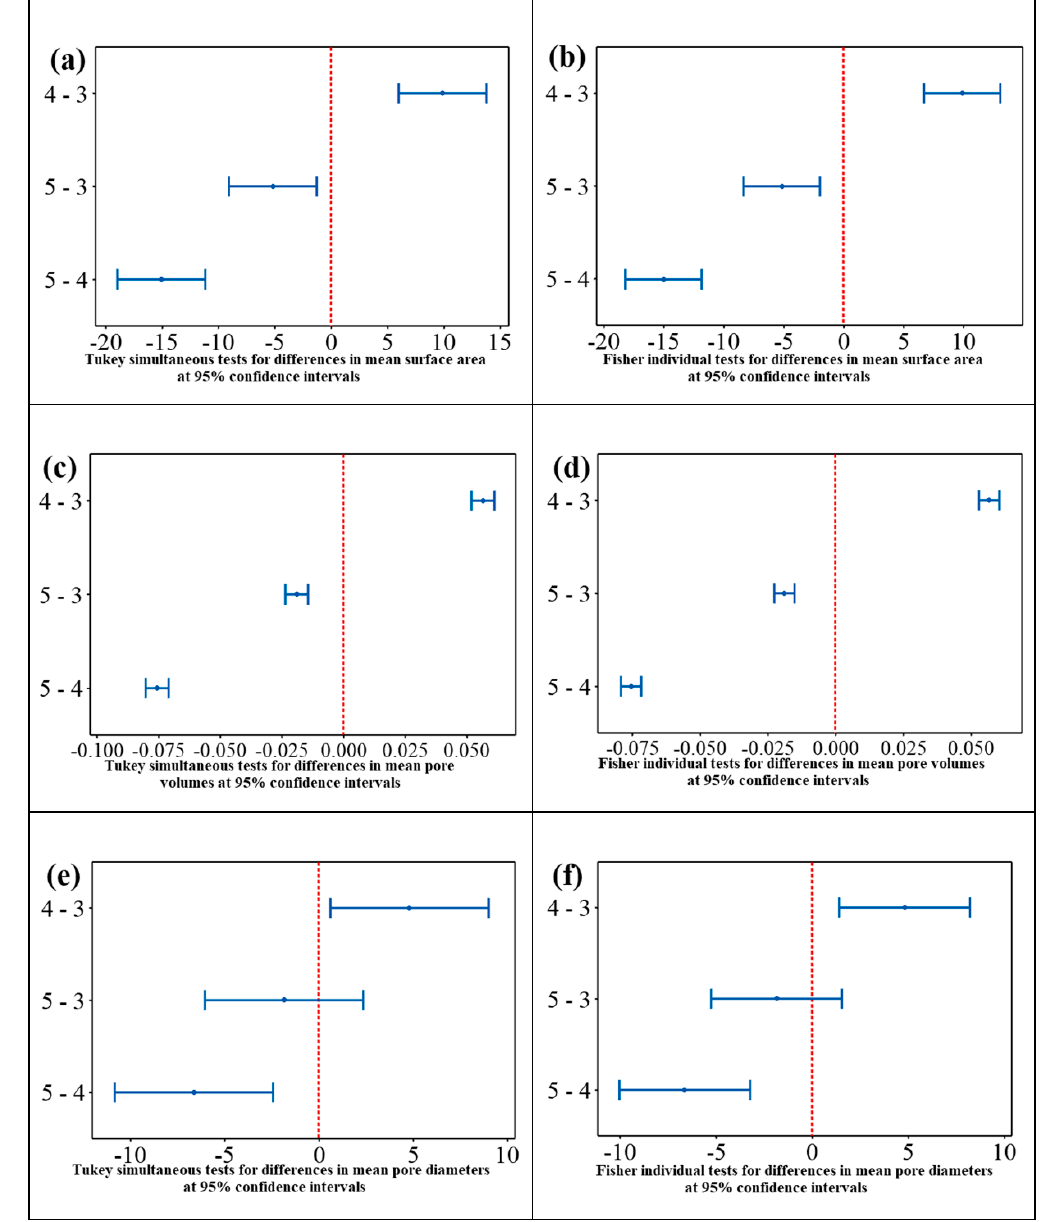
Figure 8. Tukey and Fisher tests of differences in means at 95% confidence intervals for ( a , b ) surface area, ( c , d ) pore volume, and ( e , f ) pore diameter of Fe 3 O 4 @C nanocomposite samples obtained at various hydrothermal reaction times,